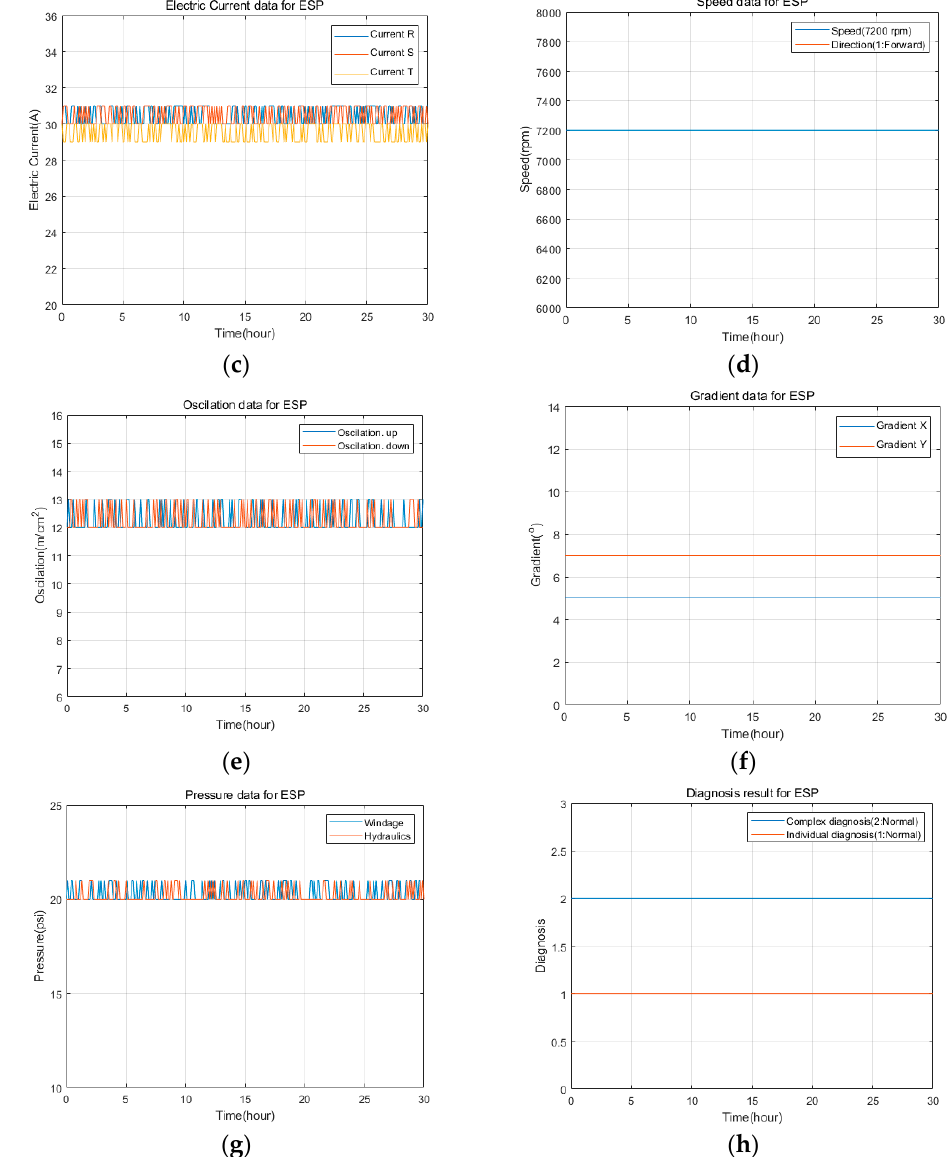
Figure 9. ESP operation state: ( a ) Temperature; ( b ) Voltage; ( c ) Current; ( d ) Speed/direction; ( e ) Oscillation; ( f ) Gradient; ( g ) Diagnosis result. ( h ) Diagnosis result.